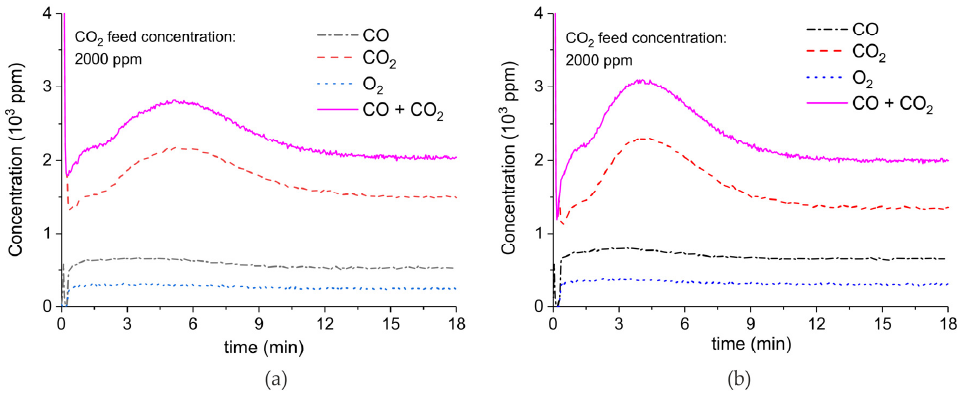
Figure A7. Concentration of the products of CaCO 3 decomposition (sample C) as function of time at 630 °C, flow rate of 90 mL/min. The fed CO 2 concentration is 1000 ppm and the plasma power is 1.3 W ( a ) and 1.5 W ( b ). The plasma is applied at the beginning of the reaction. The decomposition cycles are in order #20, #21.